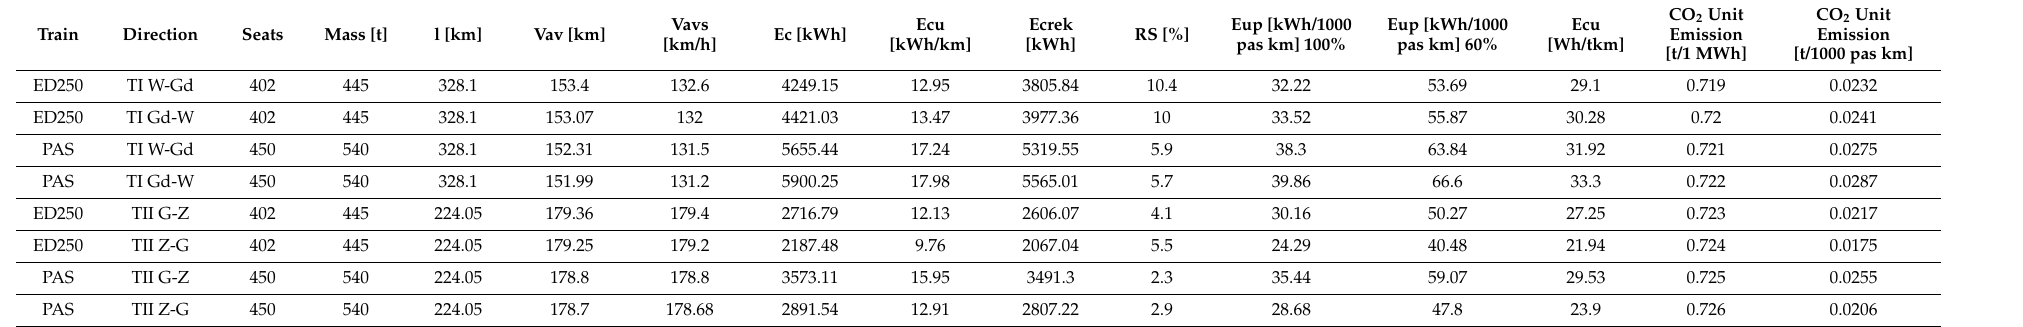
Table 6. Results of simulations trains ED250 and PAS and calculated energy and emission